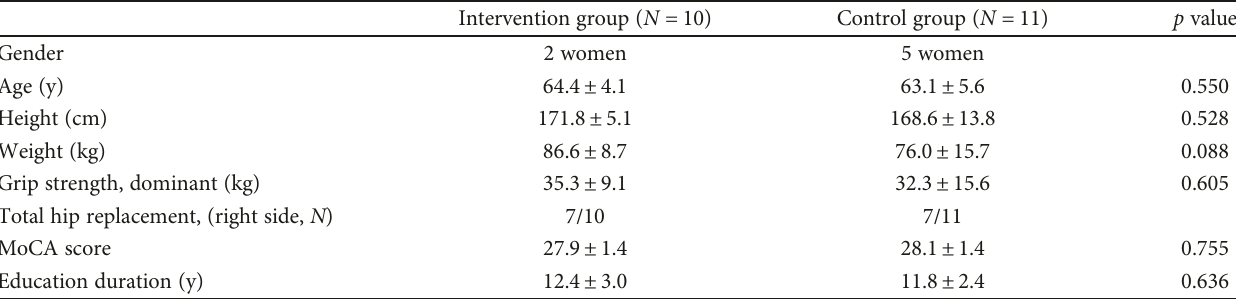
Table 1: Baseline characteristics of PANGeA hip study participants.